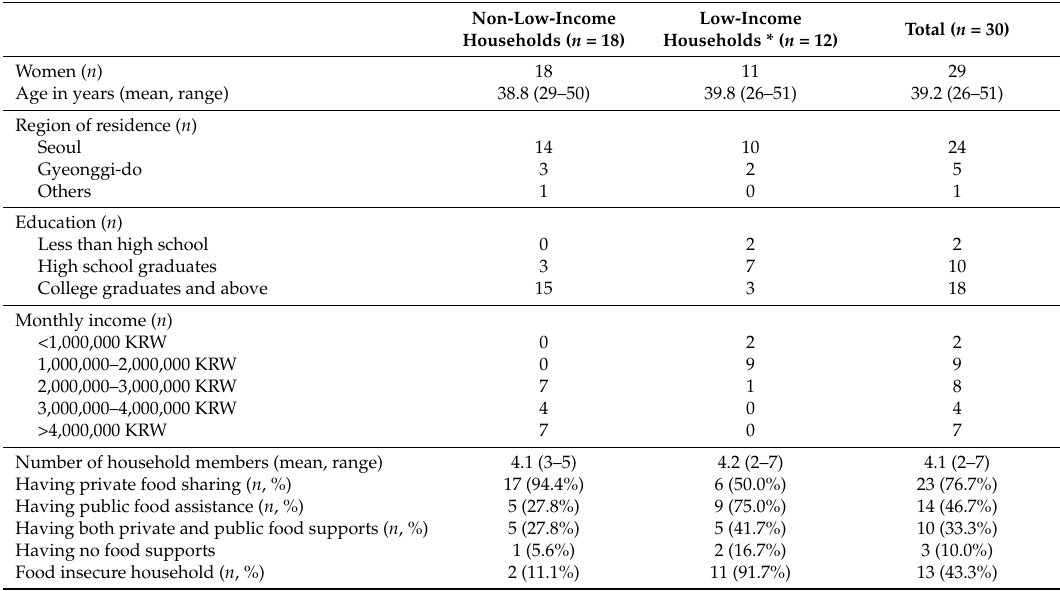
Table 2. The overall description of study participants for understanding food acquisition from private and public social networks in South